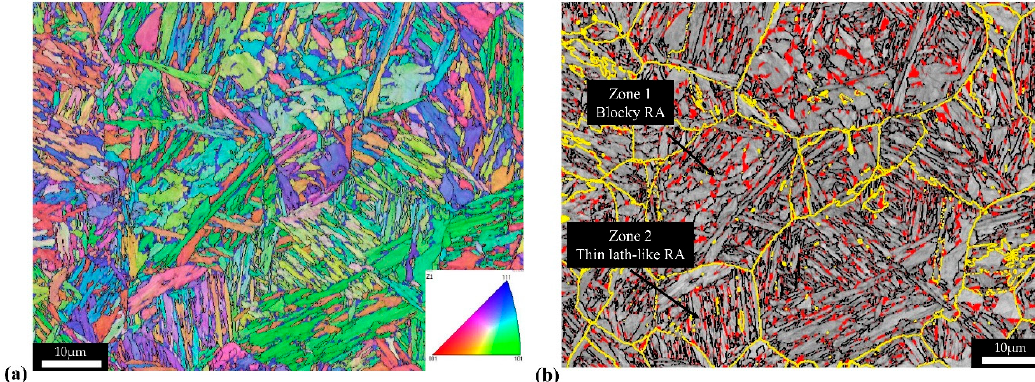
Figure 12. ( a ) Z-direction inverse pole figure (IPF-Z) map of a sample after Q&P treatment (QT = 230 ◦ C and PT / t = 400 ◦ C / 200 s) ( b ) Band contrast and 10 ◦ grain boundaries (in black) together with retained austenite (in red) and prior austenite grain boundary (PAGB) (in yellow).